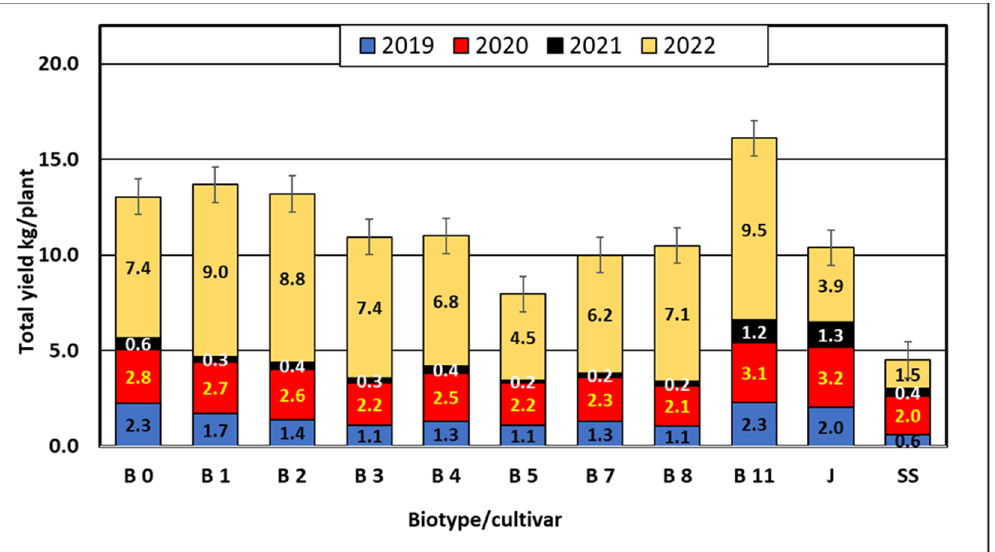
Table 6. Yield (kg ∙ plant − 1 ) of Elaeagnus multiflora biotypes and cultivars.